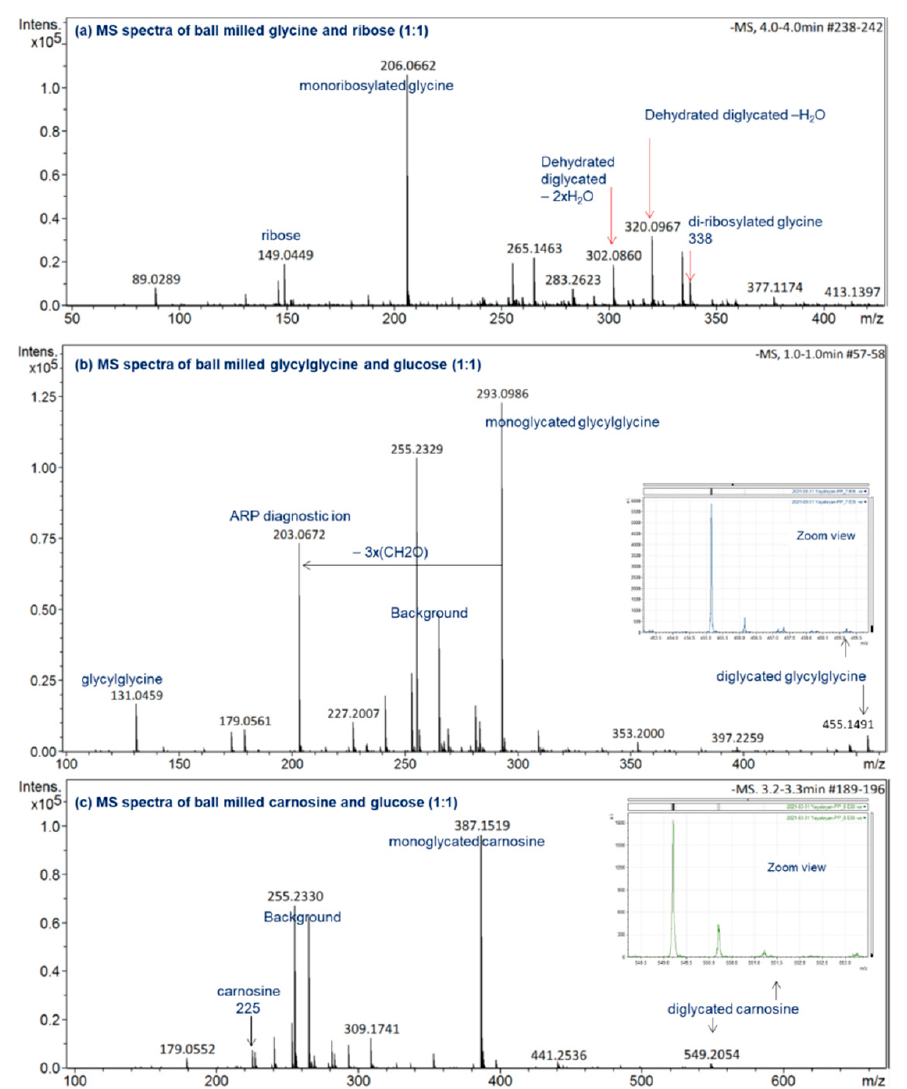
Figure 2. Comparison of the ESI( − ve)/MS spectra of the reaction mixtures of glycine/glucose (1:1) generated under ( a ) mechanochemical or ( b ) hydrothermal conditions. All identified ions are depro- tonated [M − H] − .